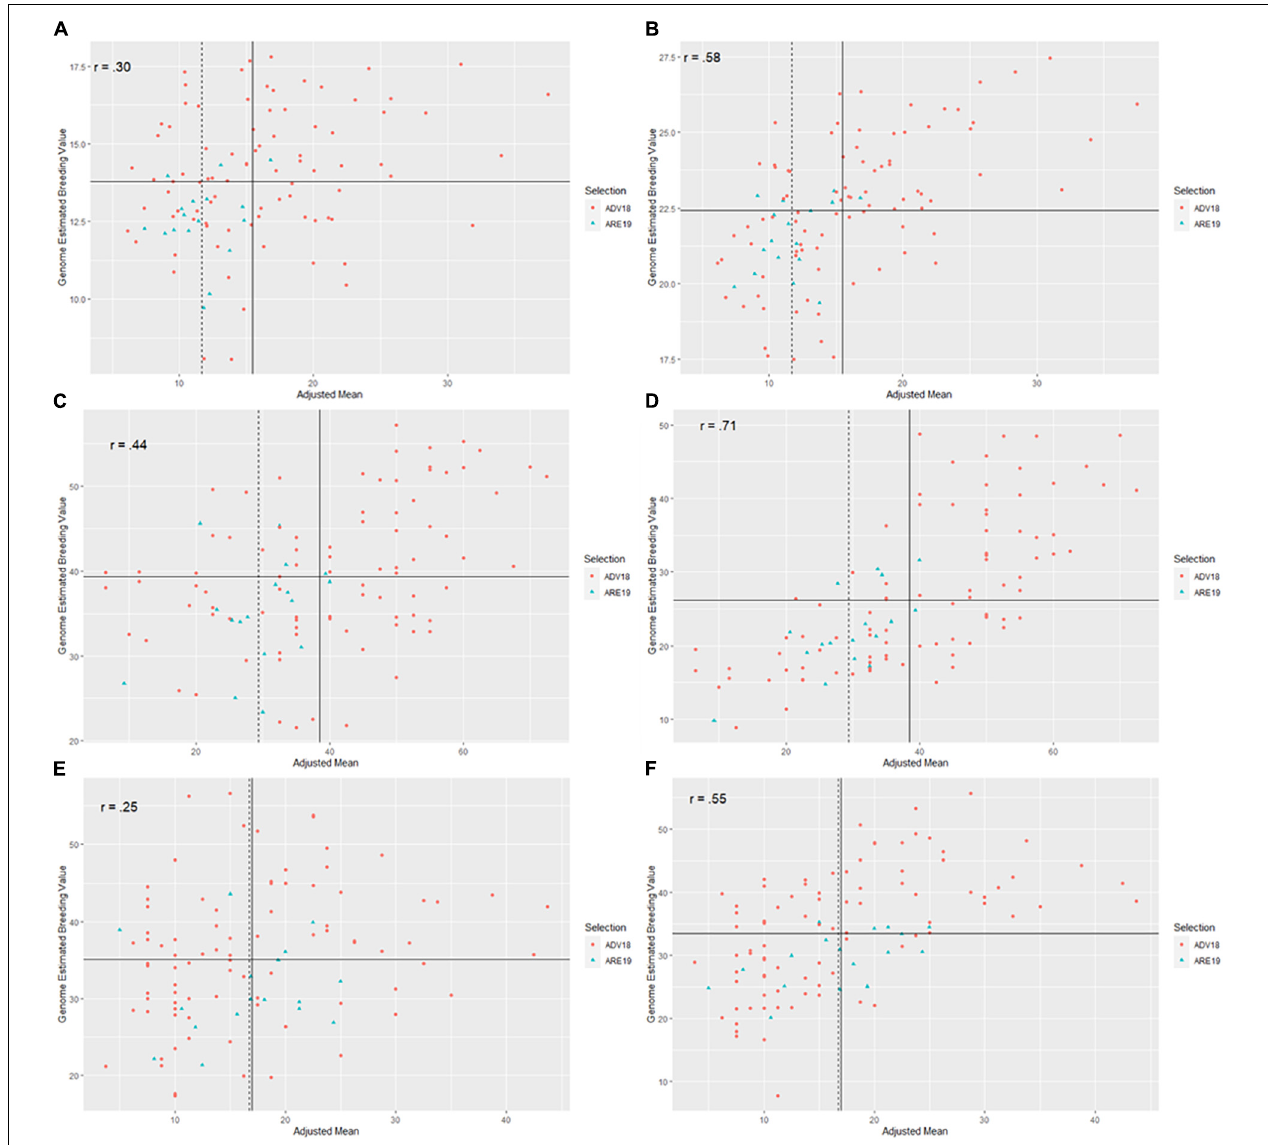
FIGURE 3 | Scatter plots between genome-estimated breeding values (GEBVs) for three Fusarium head blight (FHB) resistance traits in soft red winter wheat from two different genomic selection models (GS), including naïve models without covariates (NGS) and multi-trait GS models with covariates (MTGS), and adjusted means for deoxynivalenol (DON) concentration, Fusarium damaged kernels (FDK), and severity (SEV) across two generations, F 4 : 7 advanced from 2017 to 2018 (ADV18) and F 4 : 8 elite from 2018 to 2019 (ARE19): (A) predictions for DON in ADV18 using a NGS model, (B) predictions for DON using a MTGS model, (C) predictions for FDK from ADV18 using a NGS model, (D) predictions for FDK using a MTGS model, (E) predictions for SEV in ADV18 using a NGS model, (F) predictions for SEV using a MTGS model. The x -axis represents adjusted mean for DON, FDK, or SEV across the ADV and ARE generations. The y -axis represents the GEBVs calculated for DON, FDK, or SEV from the NGS or MTGS models. Different colored data points represent genotypes that were advanced to the next generation. The solid vertical line represents the mean of the adjusted means for the respective FHB resistance trait from the ADV generation, while the vertical dashed line represents the mean of the adjusted means for the respective FHB resistance trait from the ARE generations. The solid horizontal line represents the mean of GEBVs for the respective FHB resistance trait calculated from the NGS or MTGS models. The r label represents the Pearson correlation between GEBVs and adjusted